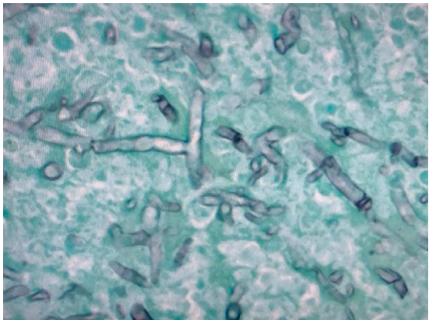
Figure 4: Gomori methenamine stain (GMS) showed abundant aseptate hyphae in the affected organs. The hyphal morphology (wide-angled, aseptate) was diagnostic of